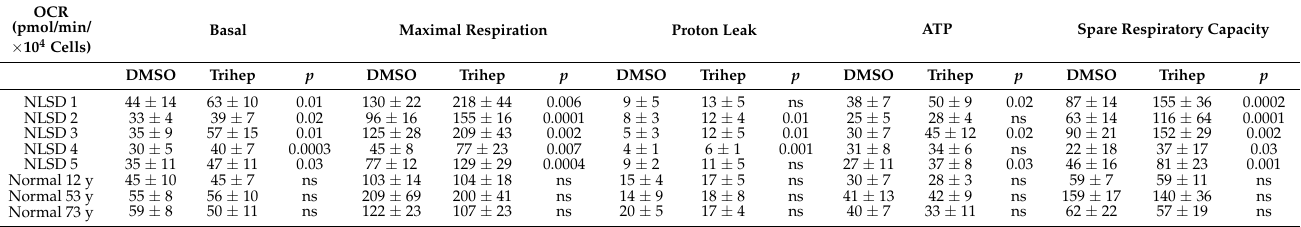
Table 2. Mitochondrial Respiration.